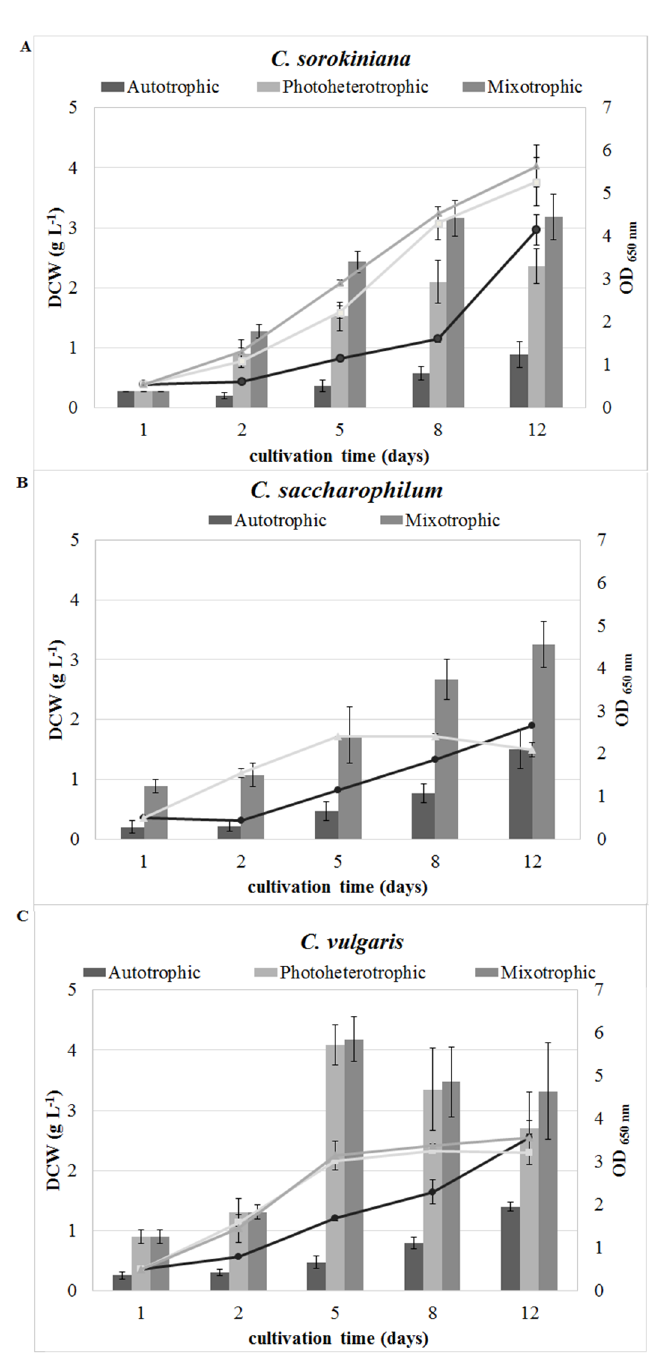
Figure 1. Influence of trophic modes on growth curves and dry weight of C. sorokiniana ( A ), C. sac- charophilum ( B ), and C. vulgaris ( C ) cells (the results are represented as mean values of measurements ± SD).